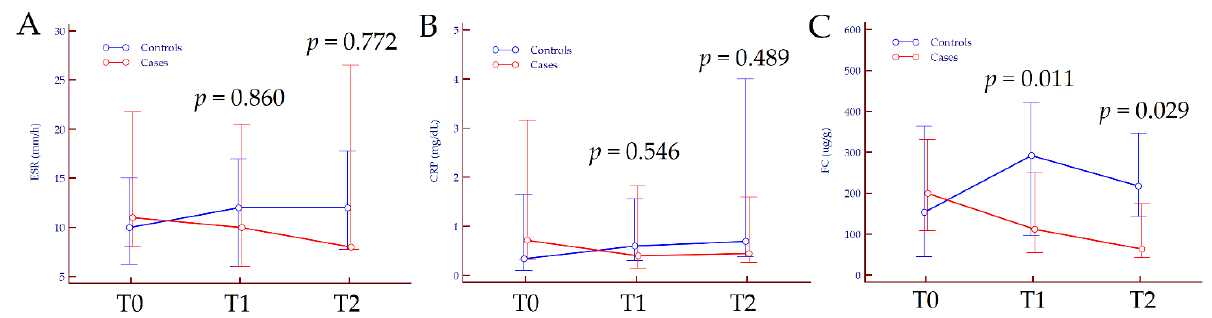
Figure 4. Variation of erythrocyte sedimentation rate ( A ), C-reactive protein ( B ) and faecal calprotectin values ( C ) from T0 to T2 according to treatment. p values refer to the comparison between groups at each time-point and were calculated by Mann–Whitney test. Abbreviations: CRP, C-reactive protein; ESR, erythrocyte sedimentation rate; FC, faecal calprotectin; T, timepoint.